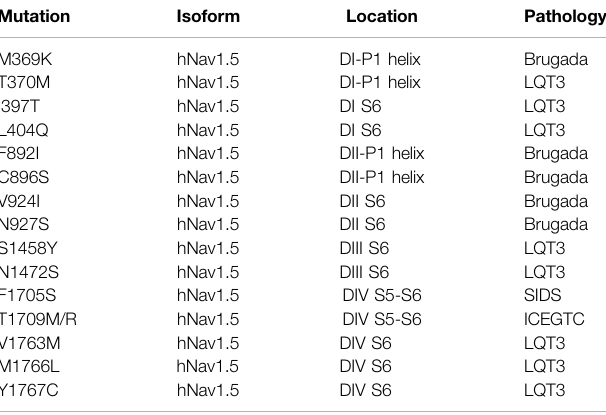
TABLE 2 | Missense mutations that target the fenestrations of hNa v 1.5 Mutation